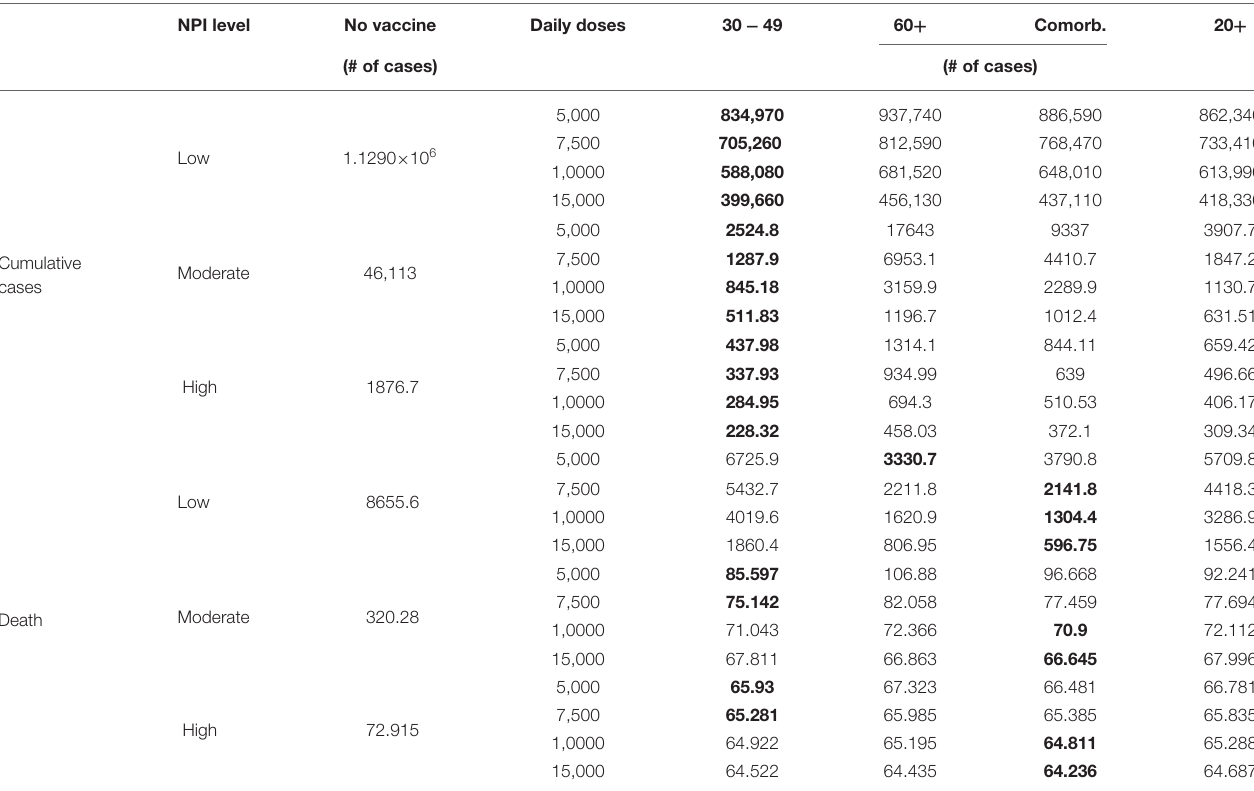
TABLE 3 | The impacts of rollout speeds (daily doses of vaccine) on cumulative age-specific infected cases and deaths are shown under three different NPI levels. NPI